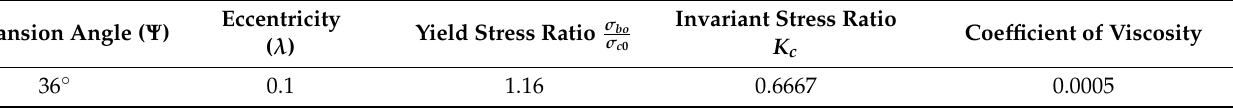
Figure 17. Constitutive relationship of the UHPC: ( a ) Tensile stress-strain relationship. ( b ) Tensile stress-strain relationship. Table 8. UHPC material parameters.